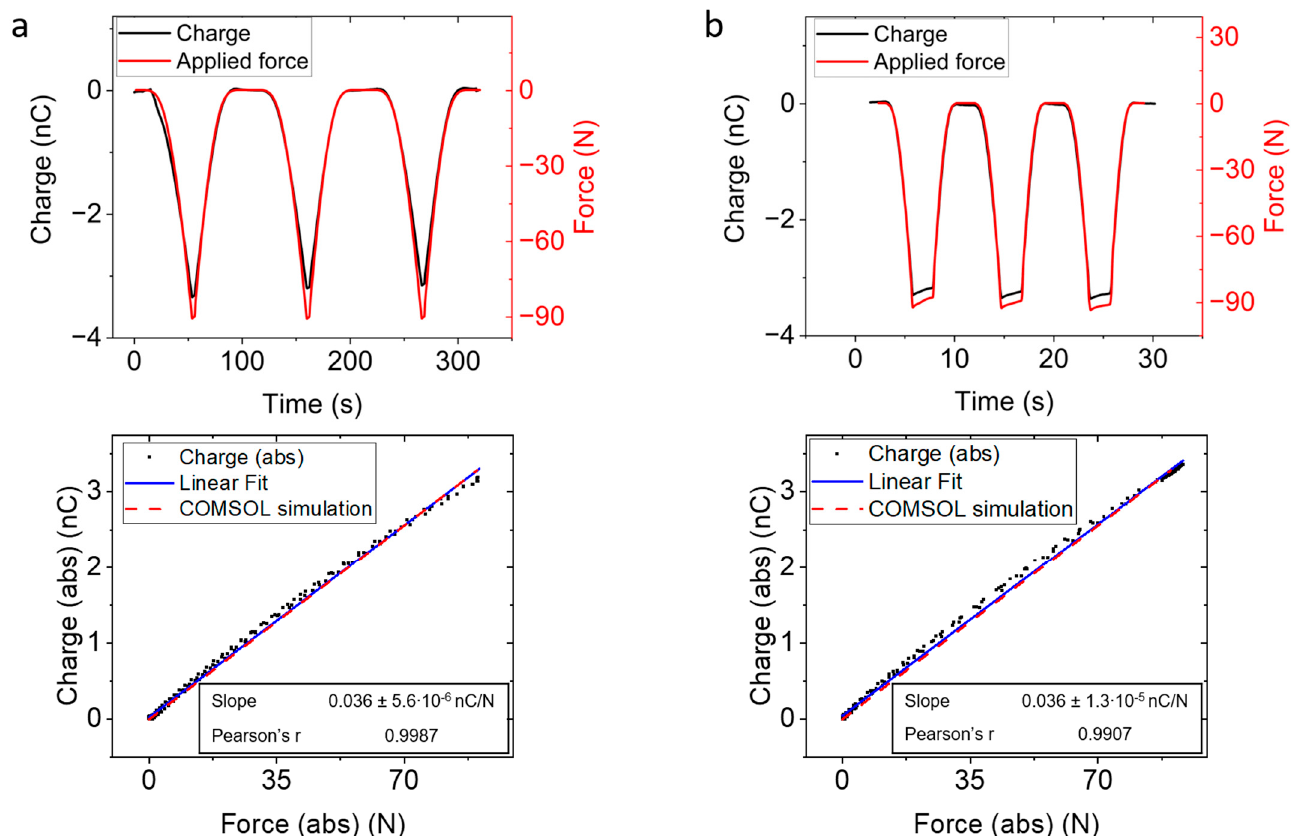
Figure 6. Temporal response of the central pixel for movement speed of ( a ) 10 µ m/s and ( b ) 150 µ m/s. On top, force and collected charge are plotted against time. On bottom, charge vs force is plotted, also including a linear fit to the experimental values (red dashed line). In blue, the simulated charge output is shown. We see both lines are close but start deviating as the force is increased. In both cases, the simulated output overestimates the experimental value. At the same time, we observe the charge output is the same for both velocities.